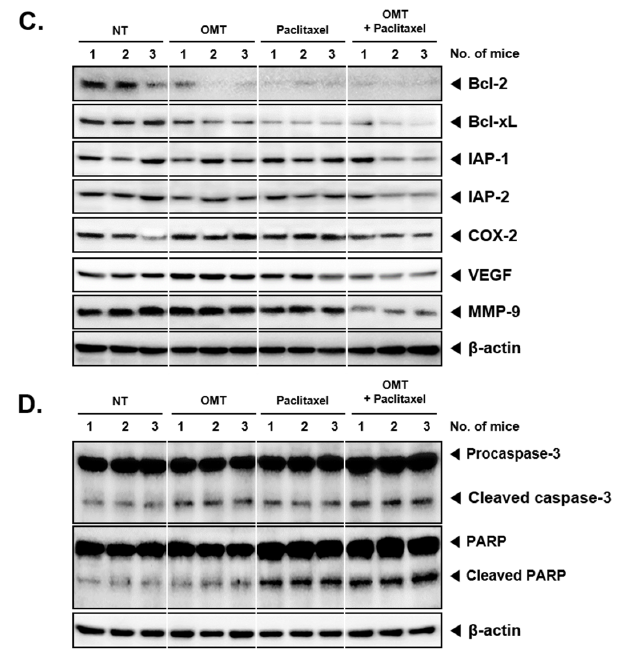
Figure 7. Effect of drug combination on cell proliferation, survival, and angiogenesis in lung cancer tissues. ( A ) OMT- and paclitaxel-treated mice tissues were analyzed by immunohistochemical analysis. Phospho-STAT5, and Ki-67 levels were detected in each treatment group and represented data were shown on the left panel. Solid tumors from the control and various treatment groups were fixed with 10% phosphate buffered formalin, processed, and embedded in paraffin. Sections were cut and deparaffinized in xylene and dehydrated in graded alcohol and finally hydrated in water. Antigen retrieval was performed by boiling the slide in 10 mM sodium citrate (pH 6.0) for 30 min. Immunohistochemistry was performed following manufacturer instructions (Vector Laboratories ImmPRESS™ REAGENT KIT). Quantification of phospho-STAT5 and the Ki-67 index was represented as mean ± SE on right panel. *** p < 0.001 compared to the control. ( B ) Western blot analysis with tissues samples showed that OMT and paclitaxel inhibited phospho-STAT5 (Tyr694/Tyr699). ( C , D ) Equal amount of lysates were analyzed via Western blot analysis and then